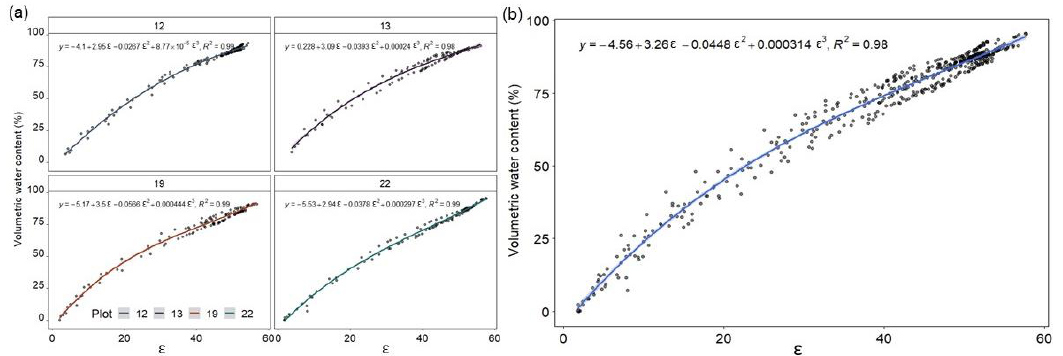
Figure 1. ( a ) Plot-based (‘single) and ( b ) whole-site (‘all-in-one’) calibration curves for the volumetric water content (%) and the electric permittivity ( ε ), including regression coefficients for the various third-order polynomial models.